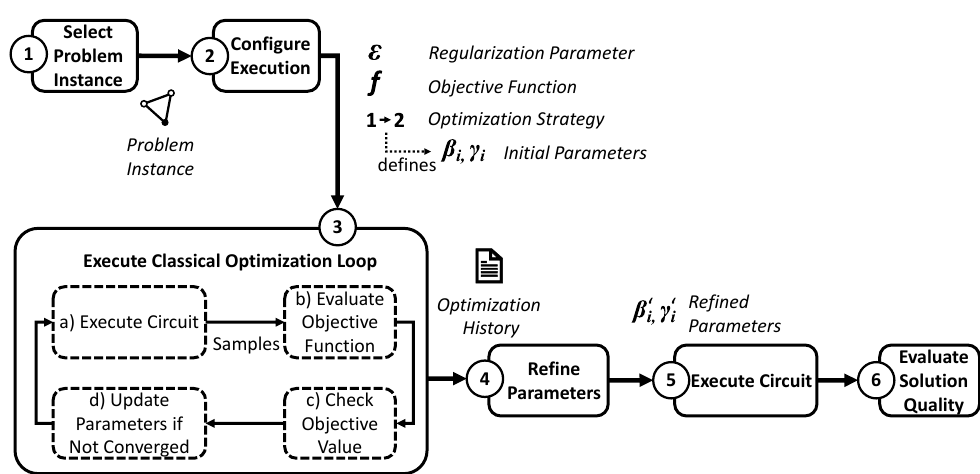
Figure 2. Overview of the WS-QAOA evaluation process.